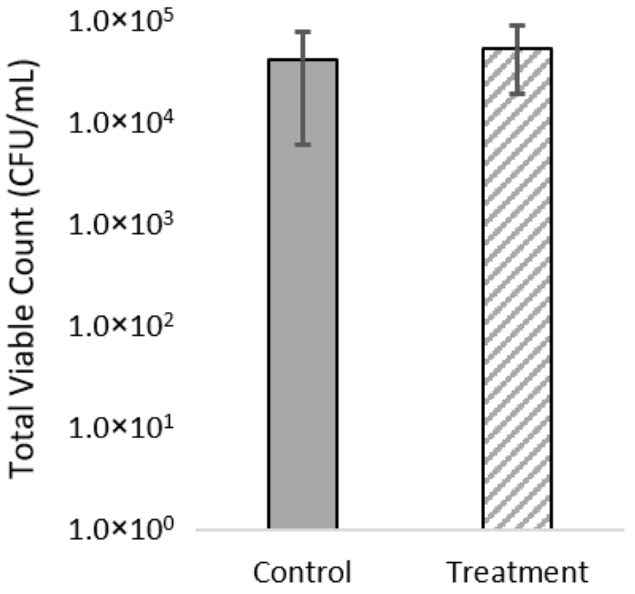
Figure 2. Counts of aerobic microbes from the gut digesta ( n = 10) from rainbow trout cultured on TSA plates at 22 °C for 24 h (log-scale).